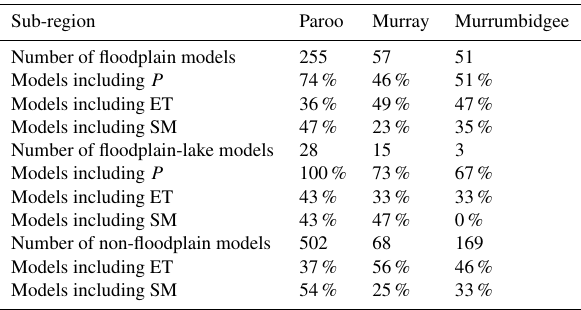
Table 7. The role of local climate variables for modeling SWE dy- namics on floodplains, showing the percentage of grid cells in each sub-region where automated variable selection led to improvements in CV-RMSE and thus inclusion of each P , ET, and SM into the final